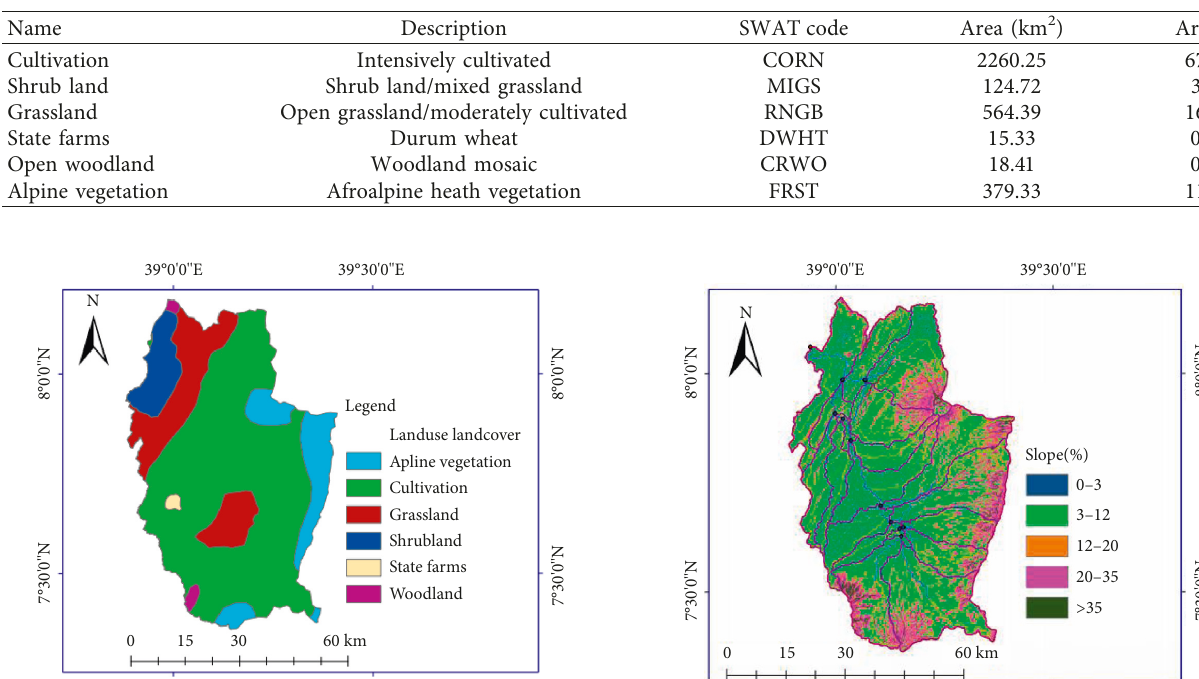
Table 3: Land use/land cover and percentage of area coverage.